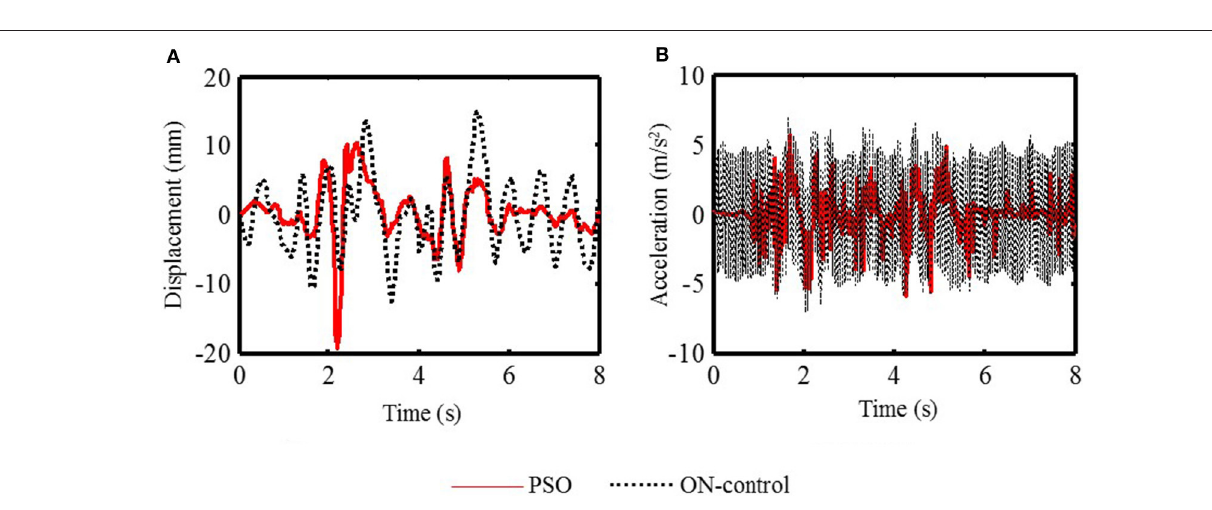
FIGURE 5 | The structural 5th floor response of the PSO control and the ON-control structure (El-Centrol). (A) The displacement response. (B) The acceleration